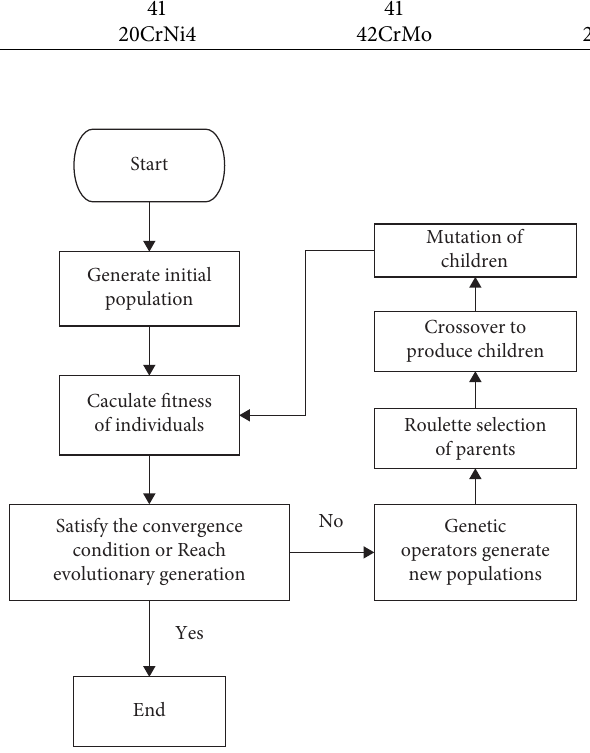
Figure 2: The flowchart of the